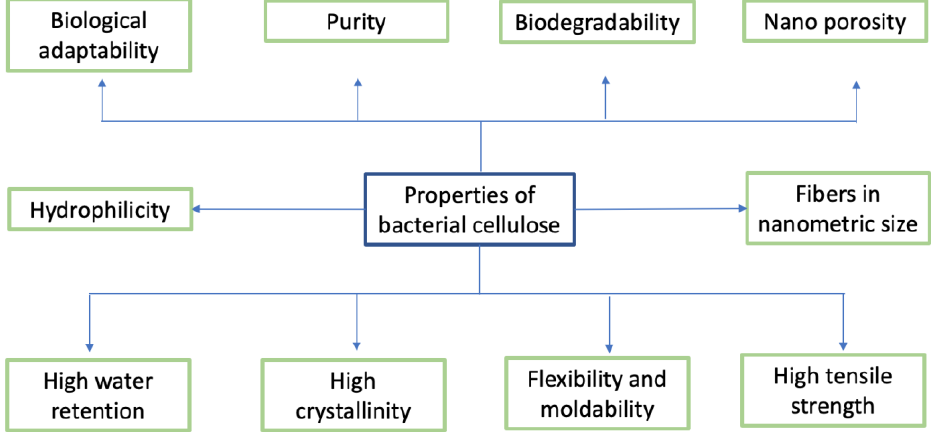
Figure 3. Main properties of bacterial cellulose.